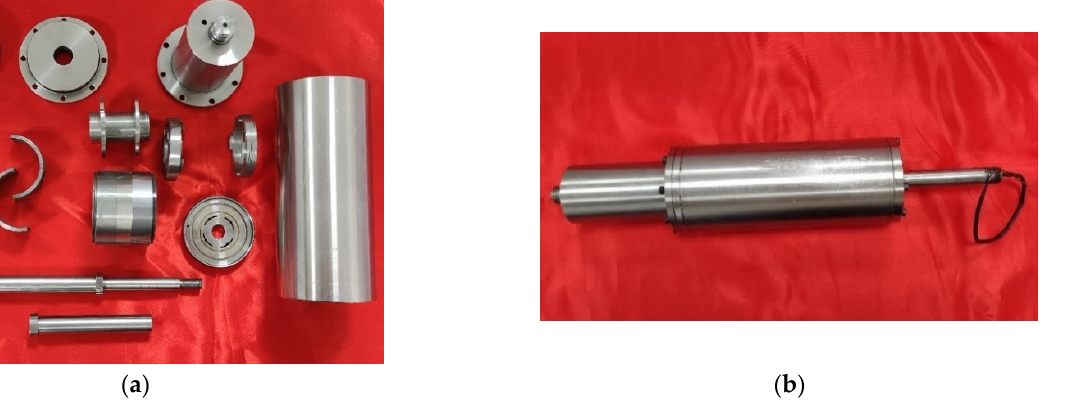
Figure 14. Optimal MR damper ( a ) components; ( b ) prototype.